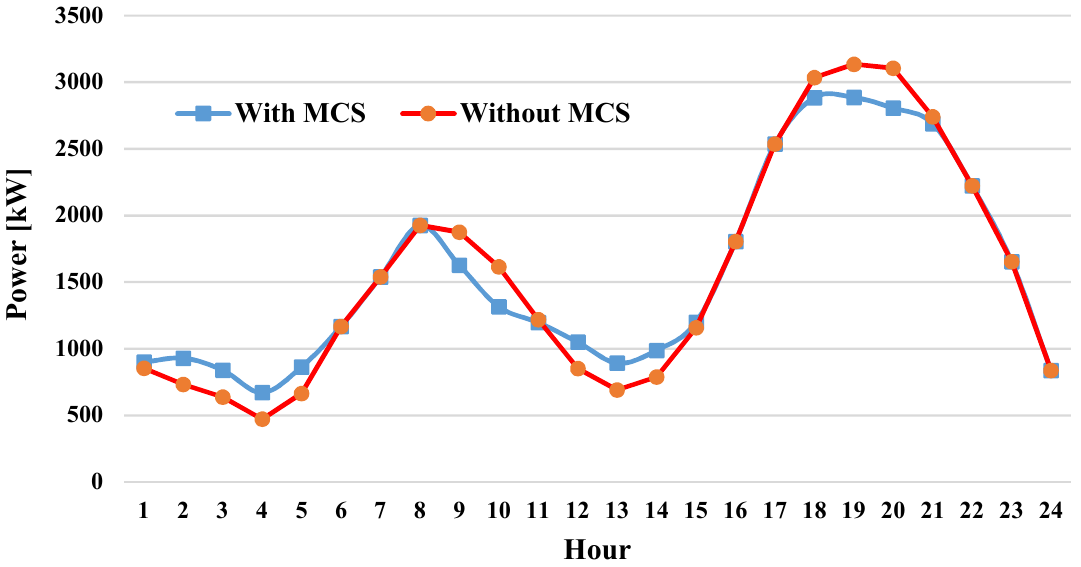
Figure 13. Total hourly power drawn from the substation.